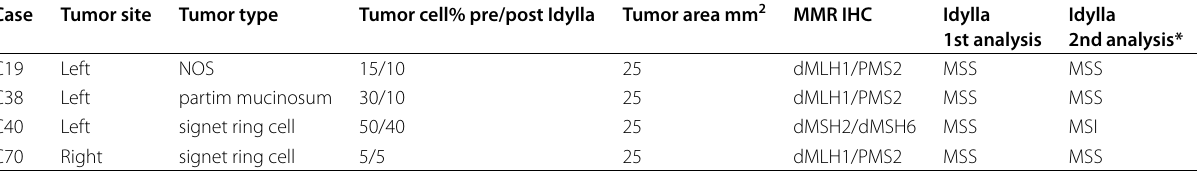
Table 1 Characteristics of the four discrepant CRC biopsy cases between MMR IHC and Idylla MSI test Case